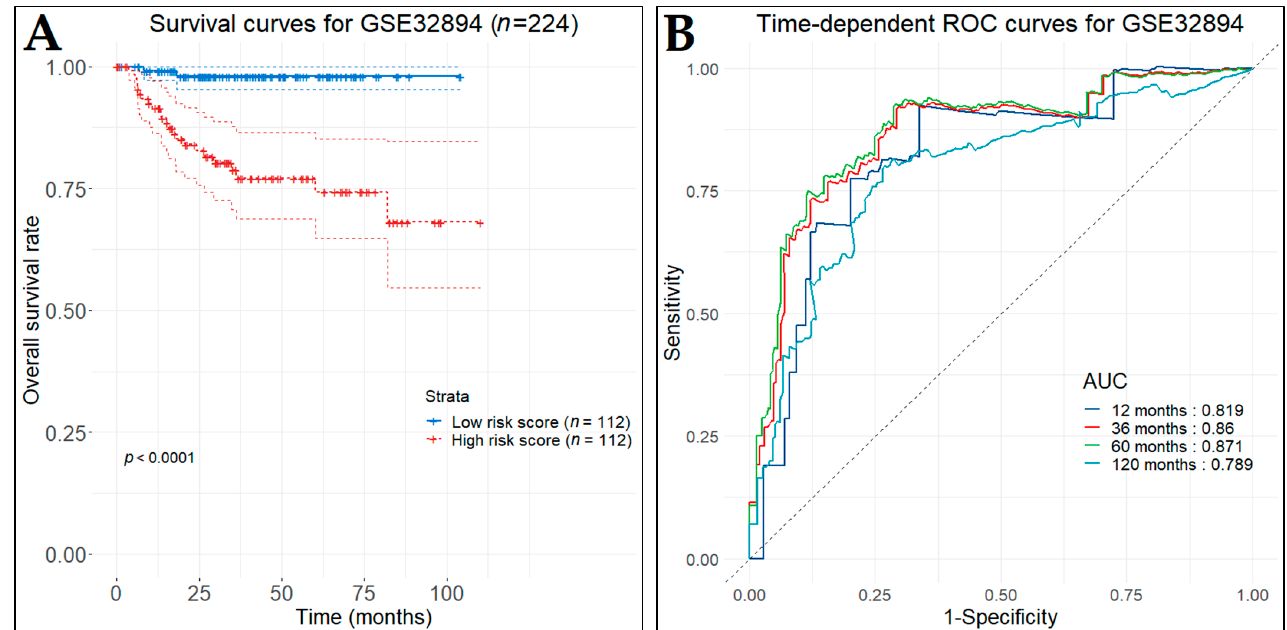
Figure 15. Survival analysis for the GSE32894 ( n = 224) dataset (first test set). ( A ) Kaplan–Meier curves for overall survival of BCa patients as stratified by the three-gene prognostic index. Patients were divided into low- and high-risk groups according to the median prognostic index. ( B ) Time- dependent ROC curves (one-, three-, five-, and ten-year predictions) to assess the prognostic accuracy of the three-gene prognostic model.